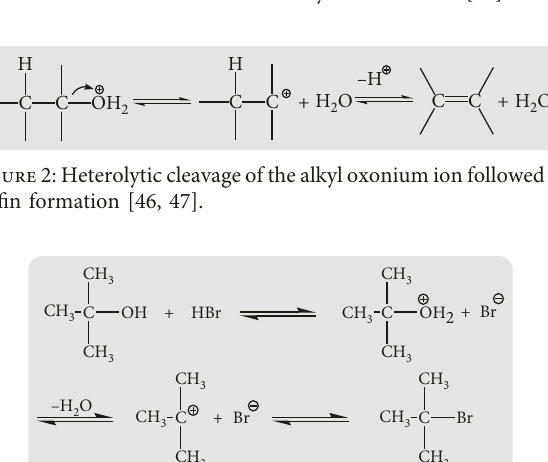
Figure 1: Formation of an alkyl oxonium ion [45].